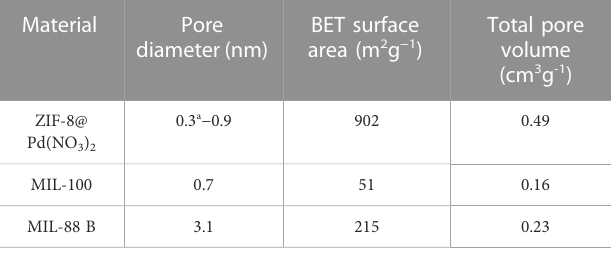
TABLE 1 Catalyst material properties from N 2 adsorption BET analysis.